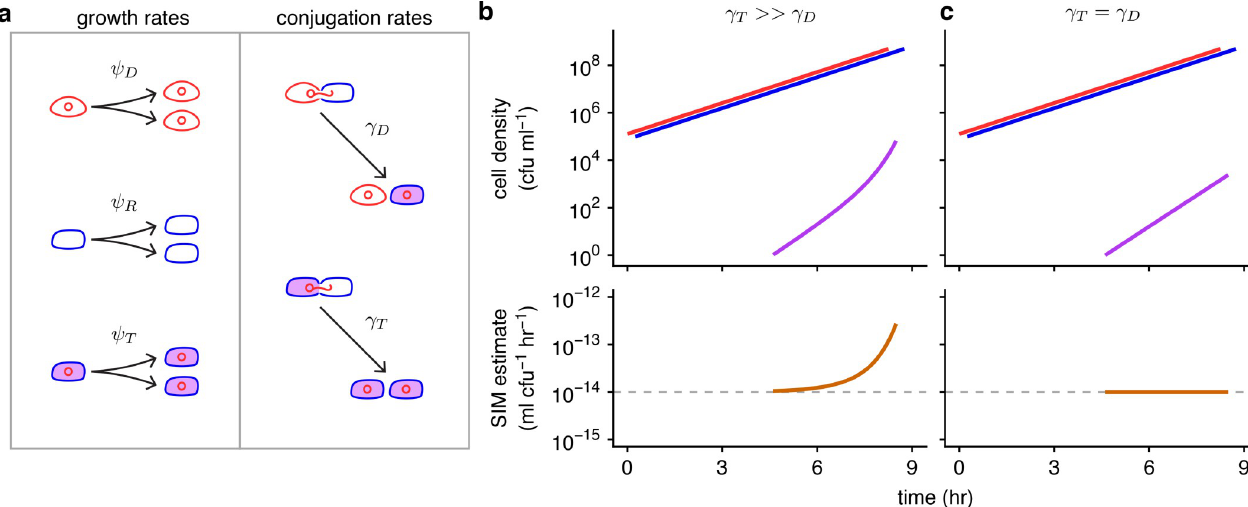
Fig 1. Basic model parameters and the effects of unequal conjugation rates on the SIM estimate. (a) In this schematic, the conjugative plasmid is a red circle, a donor is a red cell containing the plasmid, a recipient is a blue cell, and a transconjugant is indicated with a purple interior (a blue cell containing a red plasmid). The ψ D , ψ R , and ψ T parameters are donor, recipient, and transconjugant growth rates, respectively, illustrated by 1 cell dividing into 2. The γ D and γ T parameters are donor and transconjugant conjugation rates, respectively, shown by conjugation events transforming recipients into transconjugants. (b) When the transconjugant conjugation rate ( γ ) is higher than the donor conjugation rate ( γ ), transconjugants exhibit superexponential increase (purple curve) while T D donors and recipients increase exponentially (red and blue lines). The SIM estimate (orange line) increases over time, deviating from the actual donor conjugation rate (gray dashed line). (c) In contrast, when the conjugation rates are equal ( γ = γ ), the transconjugant increase is muted relative to part b T D (purple line). The SIM assumptions are met, and the estimate is constant and accurate over time (orange line). Eqs 1–3 were used to produce the top graphs, with D 0 = R 0 = 10 5 , T 0 = 0, ψ = ψ = ψ = 1, γ = 10 − 14 , and either γ = 10 − 8 (in part b) or γ = 10 − 14 (in part c). The donor and recipient trajectories D R T D T T overlapped but were staggered for visibility. Eq 4 was used to produce the bottom graphs. The code needed to generate this figure can be found at https:// github.com/livkosterlitz/LDM or https://doi.org/10.5281/zenodo.6677158.